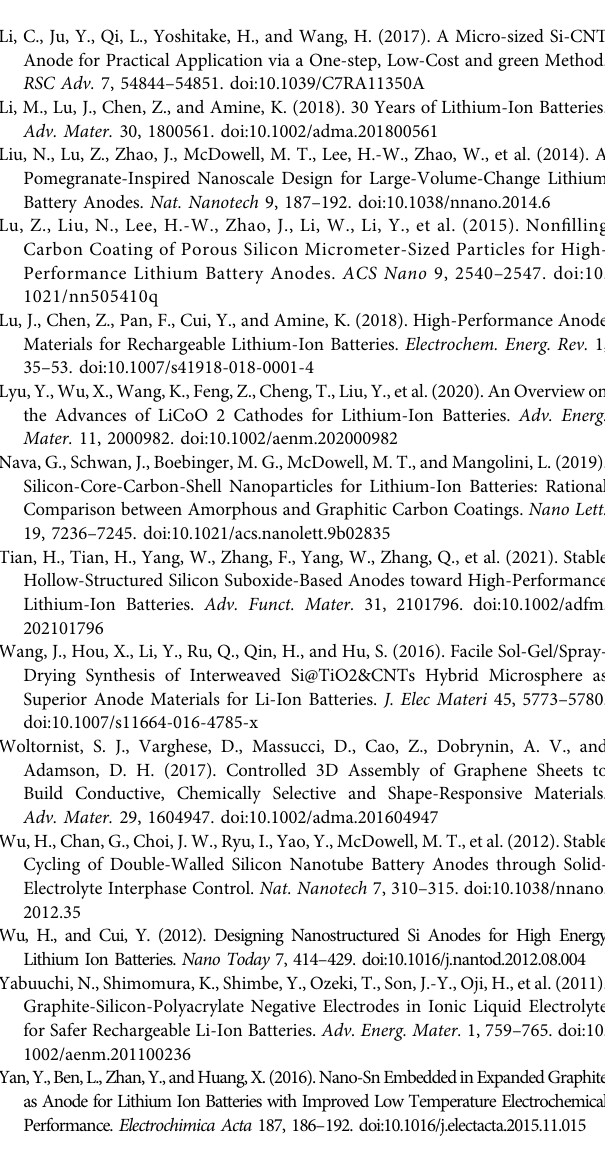
Supplementary Figure S1 | Schematic diagram of the spray equipment. Supplementary Figure S2 | TEM images of Si@PMMA materials. Supplementary Figure S3 | TEM images of Si@PMMA@PDA